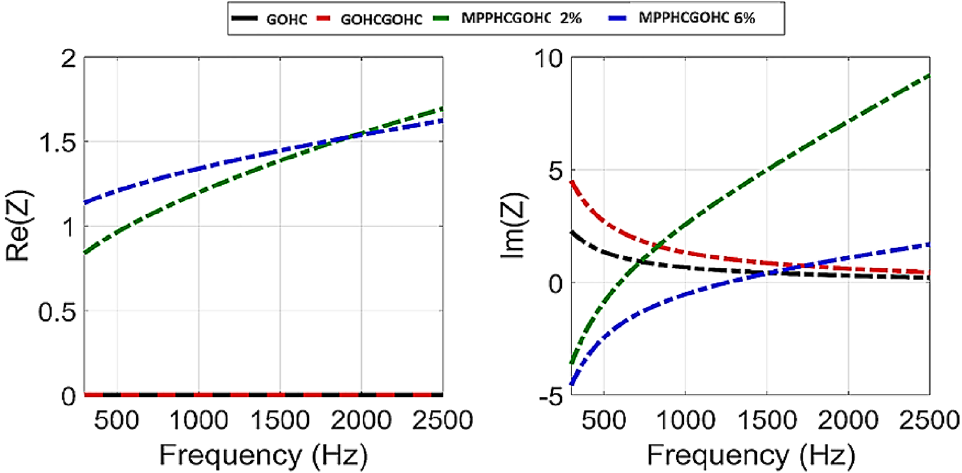
Figure 5. Acoustic Reactance (Im(Z T )) and Acoustic Resistance (Re(Z T )) for the proposed Hybrid metamaterial structures: GOHC, GOHCGOHC, MPPHCGOHC with 2% of perforation ratio and MPPHCGOHC with 6% of perforation